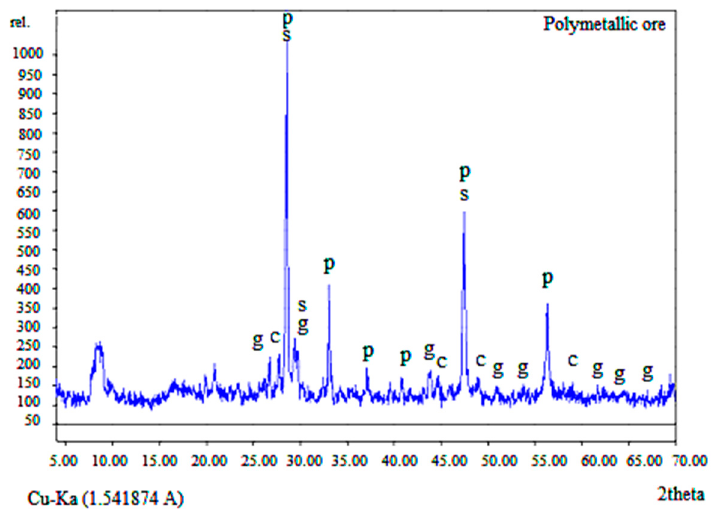
Figure 1. X-ray di ff raction pattern of the concentrate where p—pyrite; s—sphalerite; g—galena Figure 1. X-ray diffraction pattern of the concentrate where p—pyrite; s—sphalerite; g—galena and and c—chalcopyrite. c—chalcopyrite.